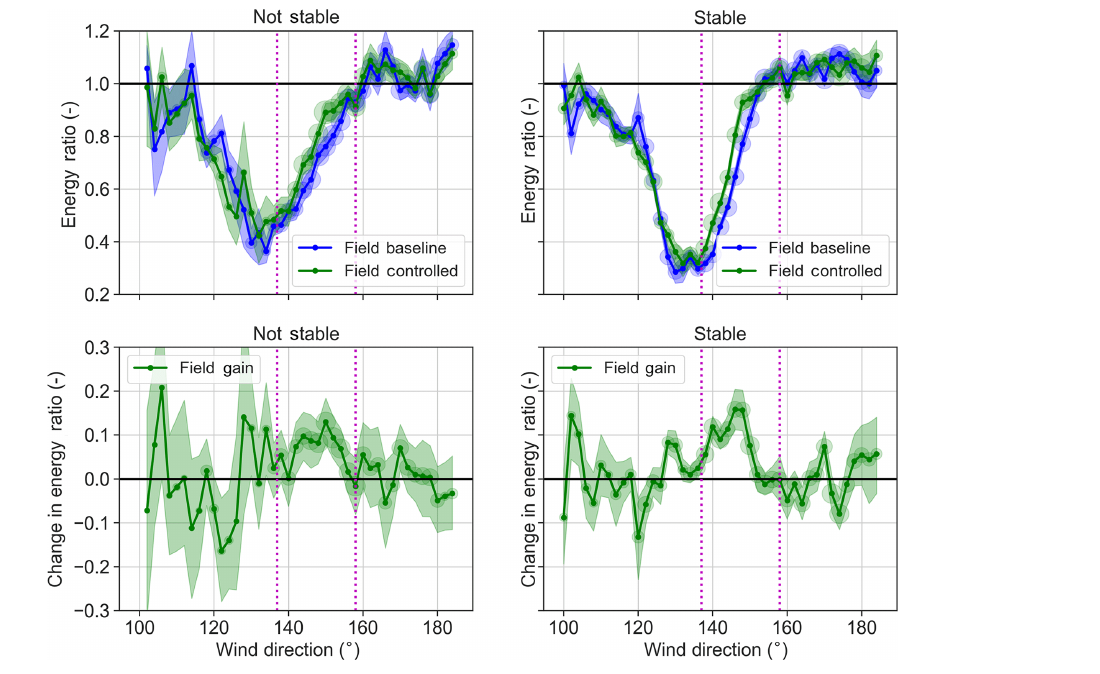
Figure 13. Energy ratio of T3, as in Fig. 11, divided into stable and unstable conditions.